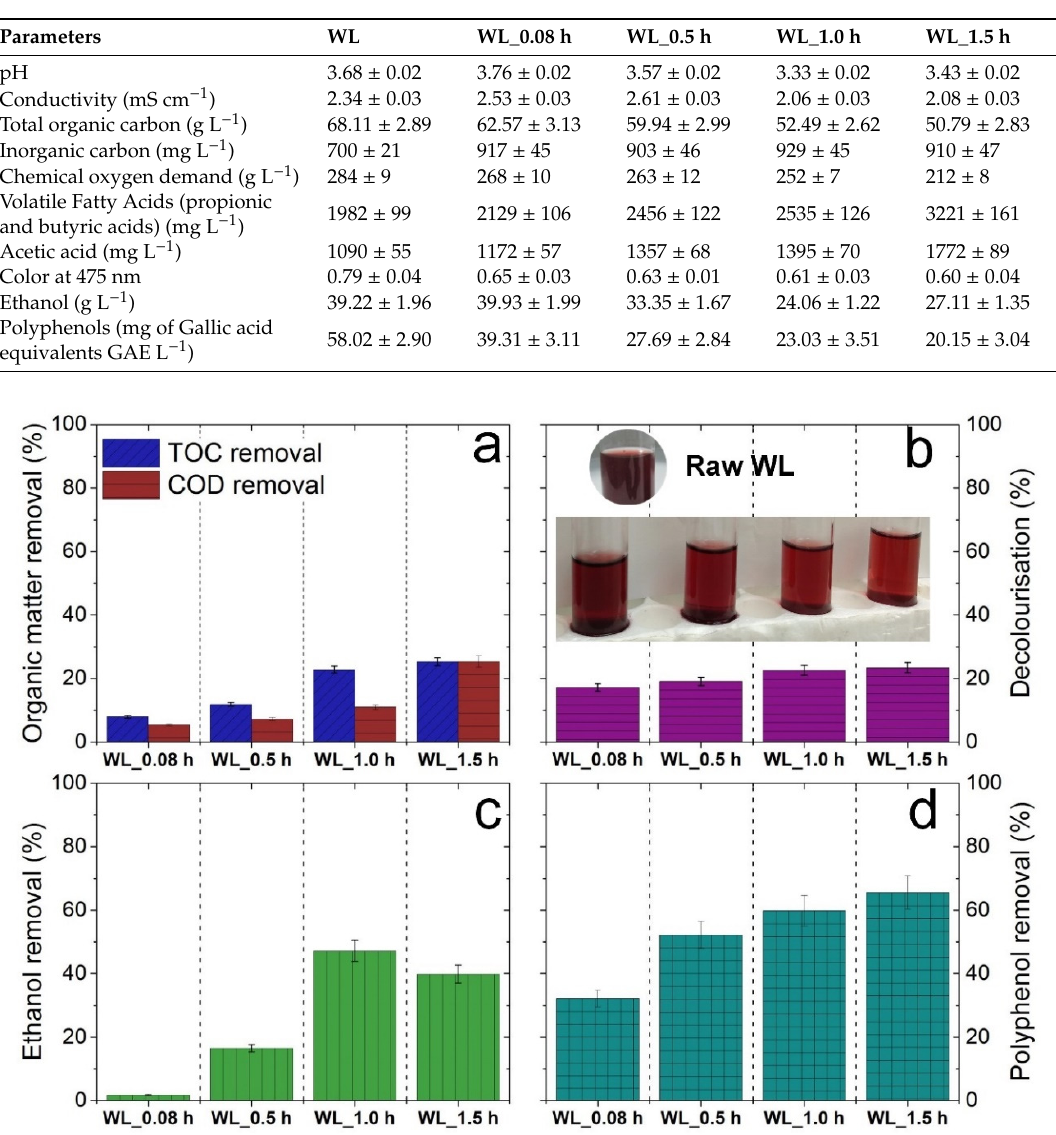
Table 4. Results of electro-oxidation (EO) tests.